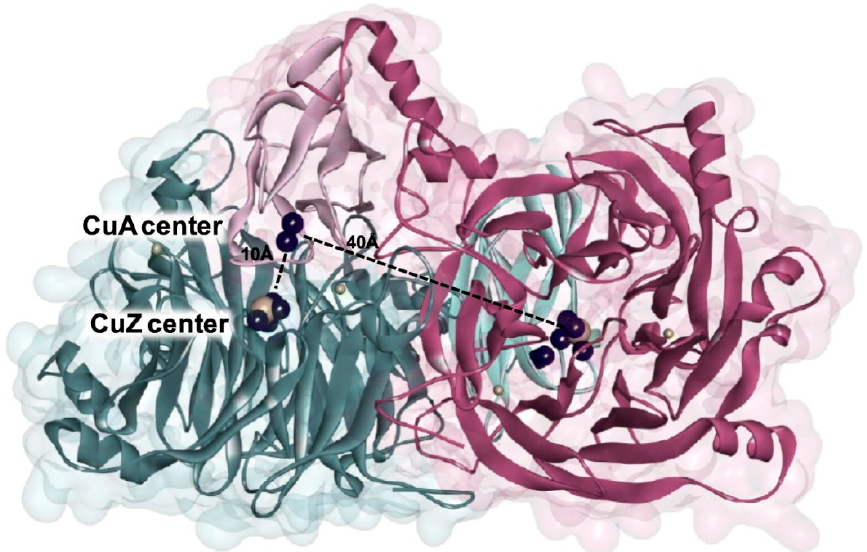
Figure 3. Structure of Marinobacter hydrocarbonoclasticus nitrous oxide reductase (N 2 OR) homodimer. N 2 OR is organized as a head-to-tail homodimer. Monomers are coloured differently so that they can be distinguished. In both monomers, the N-terminal domain is dark-coloured. The N-terminal domain forms a seven-bladed β -propeller fold that coordinates the catalytic tetranuclear active site Cu Z through seven histidine residues at its hub. The C-terminal domain forms a cupredoxin fold and binds the dinuclear mixed-valent Cu A centre [104].